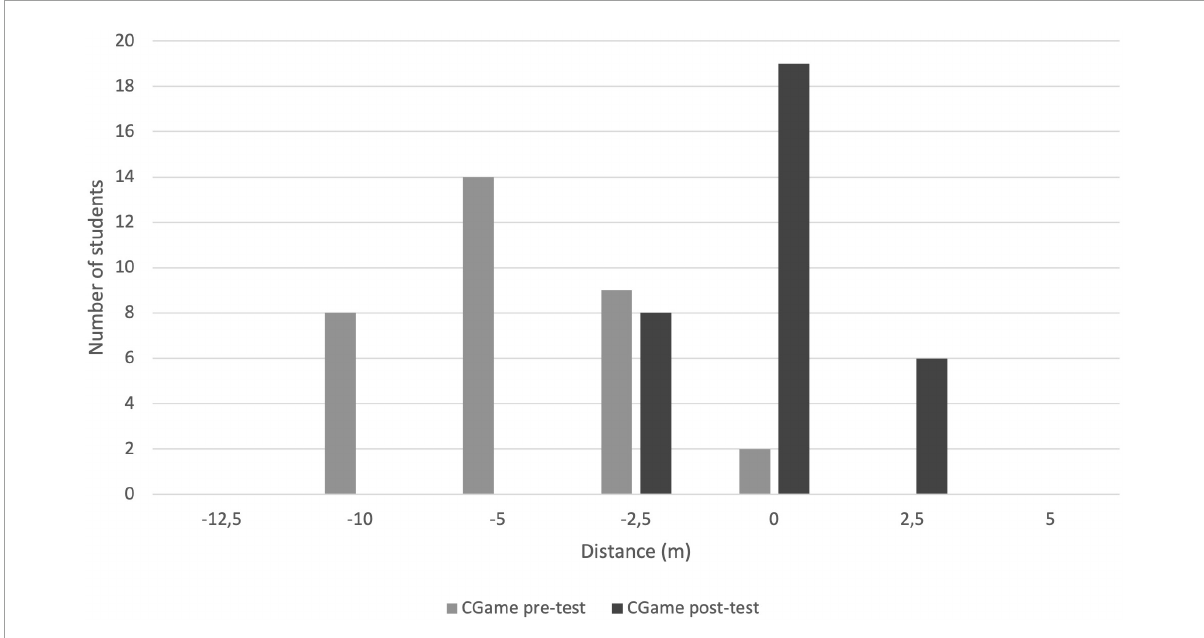
FIGURE3 Difference between prediction and maximum pre-test and post-test apneas for the CGame group. The differences before and after the exercise of the CGame are significant (Chi 2 = 41.82, dof = 1, r < 0.001). The conjunctions between saying and doing are much closer at the end of the